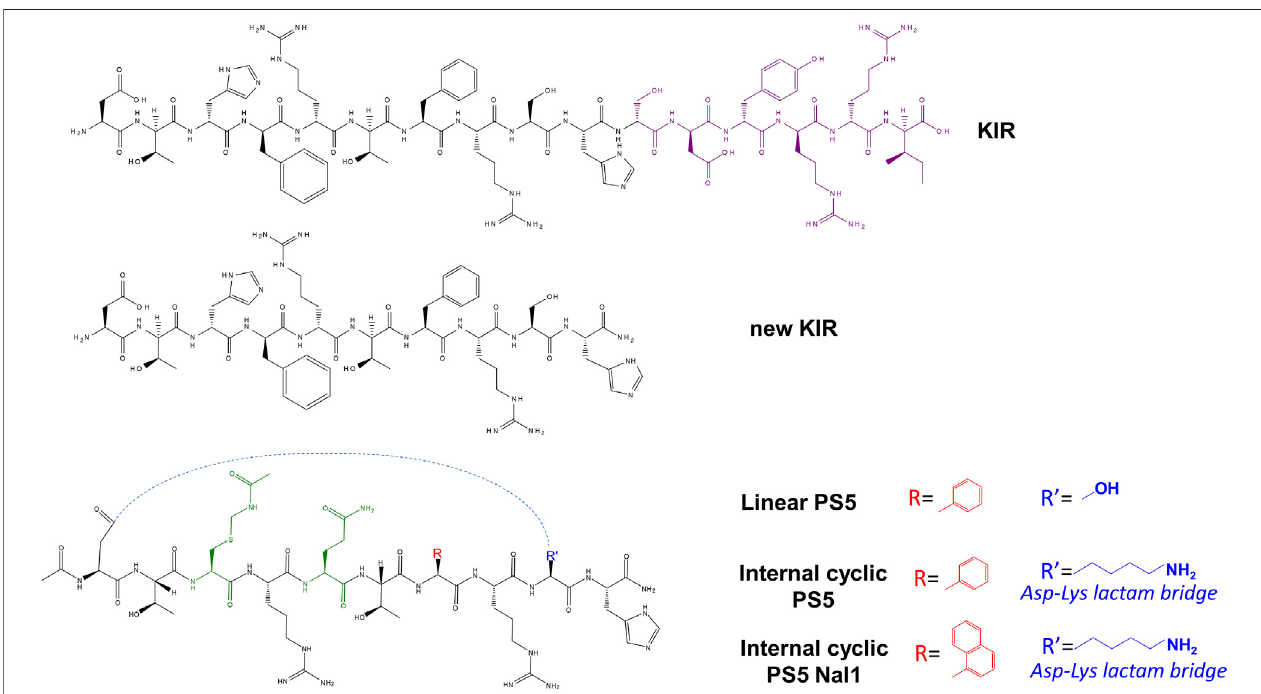
FIGURE2| Chemical structures ofKIR-based SOCS1 proteomimetics.Greenrepresentsnon-native residues in PS5uponcombinatorial modi fi cations (Cys(Acm) and Gln), blue represents the residue is alternatively Ser 60 in PS5 and Lys in internal cycles PS5 for the formation of lactam bridge (with Asp 52 ), and red represents the aromatic residue Nal1 or Phe 56 .